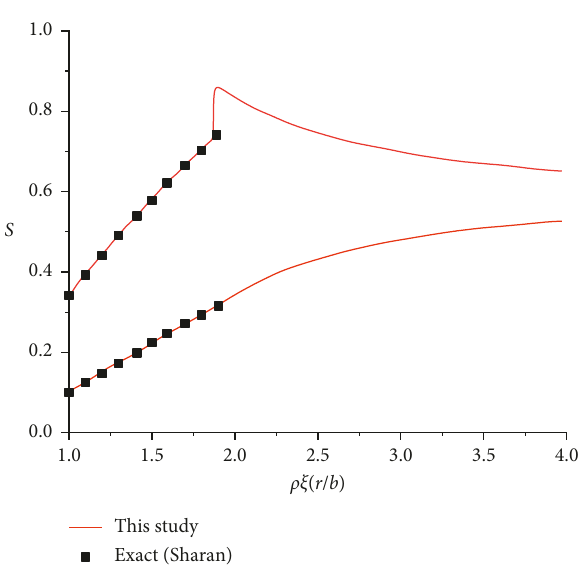
Figure 6: Distribution of errors between dimensionless stresses and exact stresses.